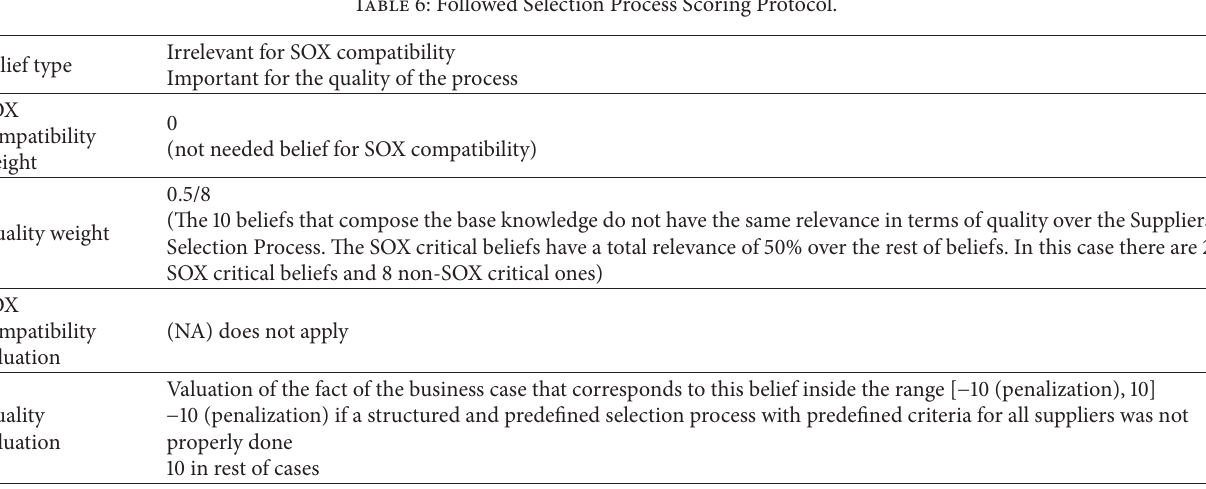
Table 6: Followed Selection Process Scoring